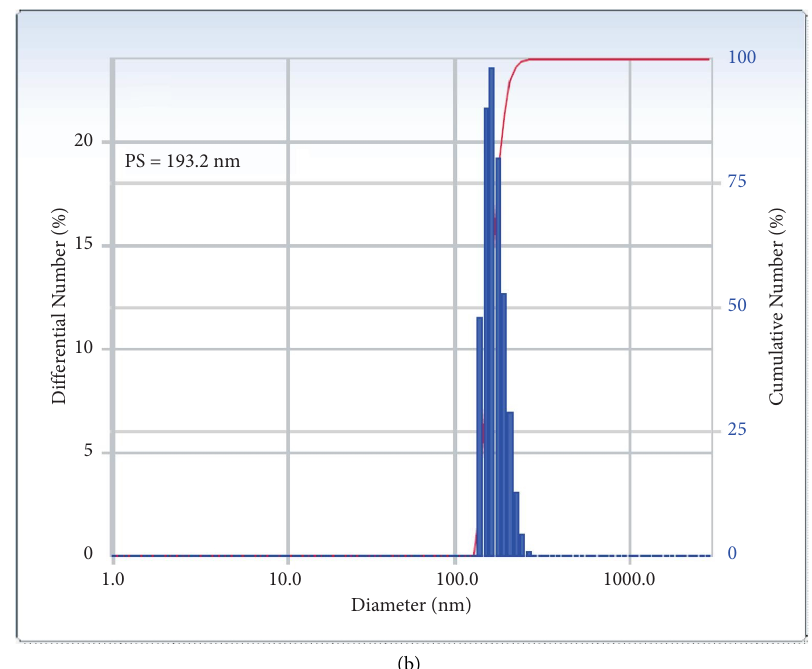
Figure 6: DLS of (a) GO-MNPs and (b) GD-MNPs.